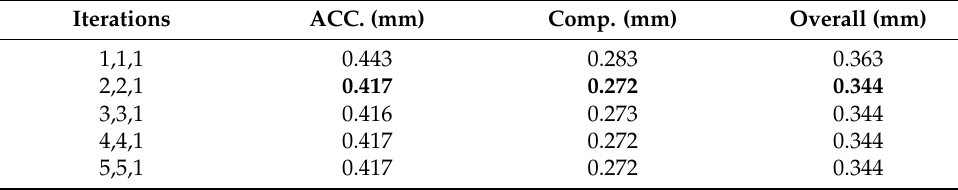
Table 6. Effect of different iterations on the experimental